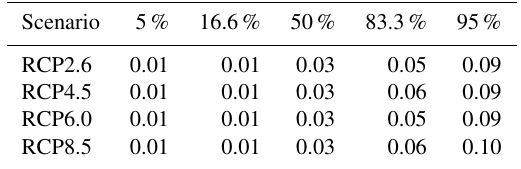
Table 15. Sea level contributions from basal ice shelf melting from Antarctica between 2020 and